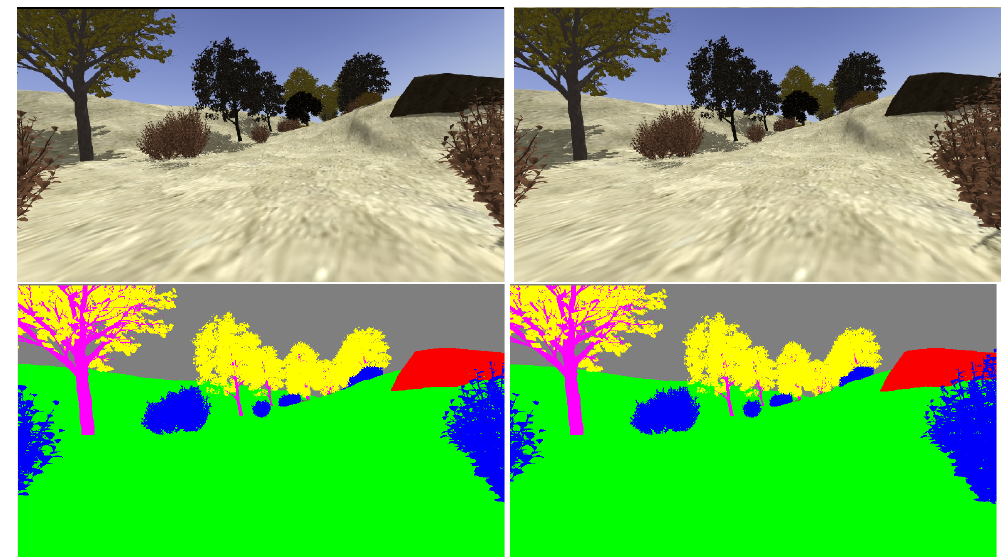
Figure 20. Realistic ( up ) and tagged ( down ) stereo image pairs ( left-right ) taken from the hillside environment.